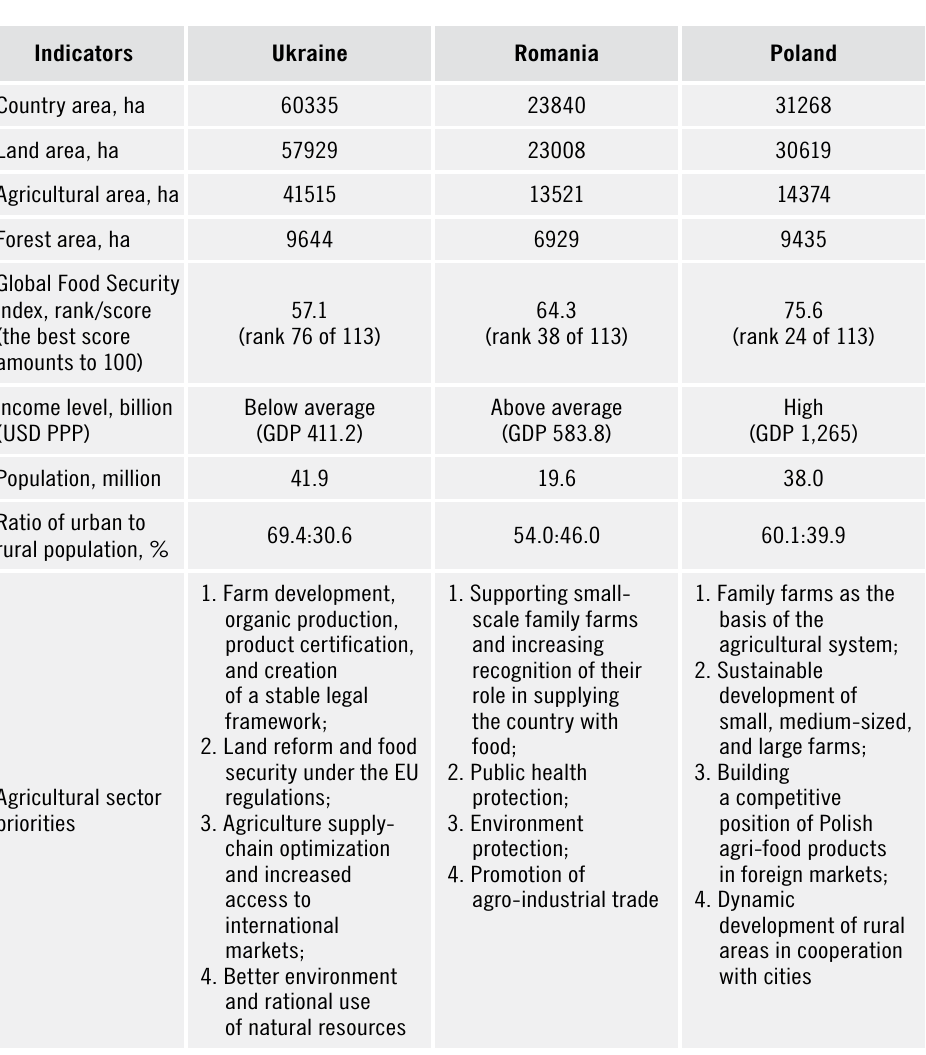
Table 1. Food and agriculture potential, 2019 Indicators